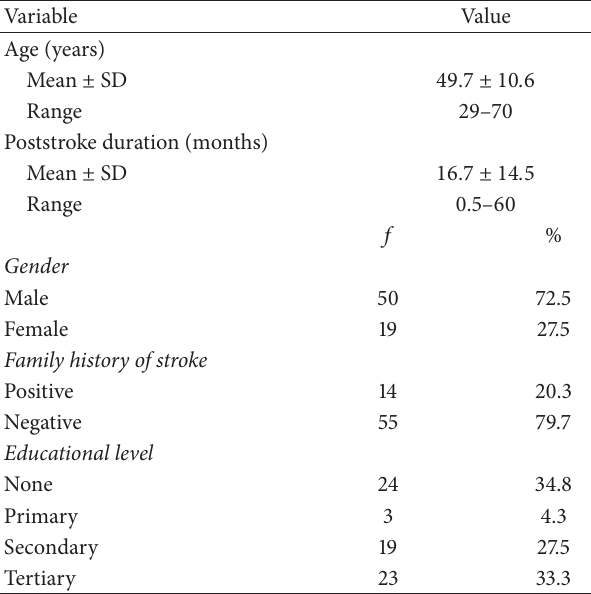
Table 4: Logistic regression analysis for determinants of knowledge of stroke risk